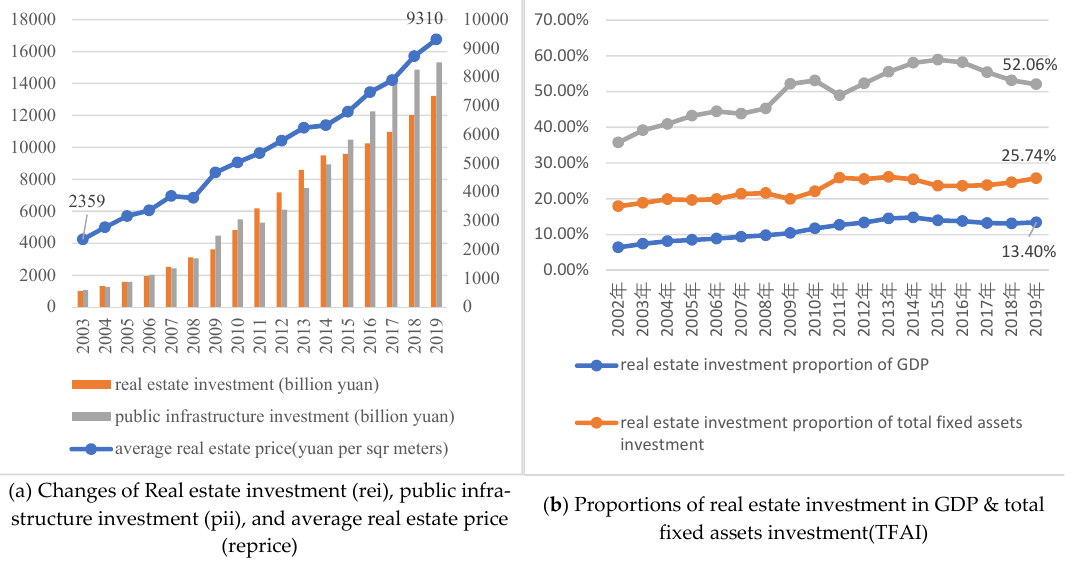
Figure 2. Real estate investment (rei), public infrastructure investment (pii), and average real estate price (reprice) and the real estate investment (rei) proportion of GDP and total fixed assets investment (TFAI) in China. Source: National Statistical Bureau.